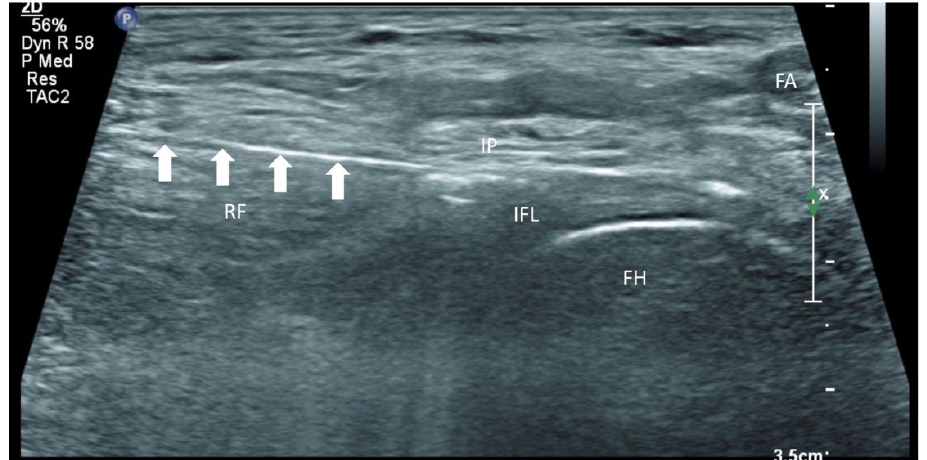
Figure 5. Ultrasound image showing the iliopsoas plane infiltration. FA: femoral artery, FH: femoral head, IP: iliopsoas, RF: rectus femoris, IFL: iliofemoral ligament; white arrow: needle.